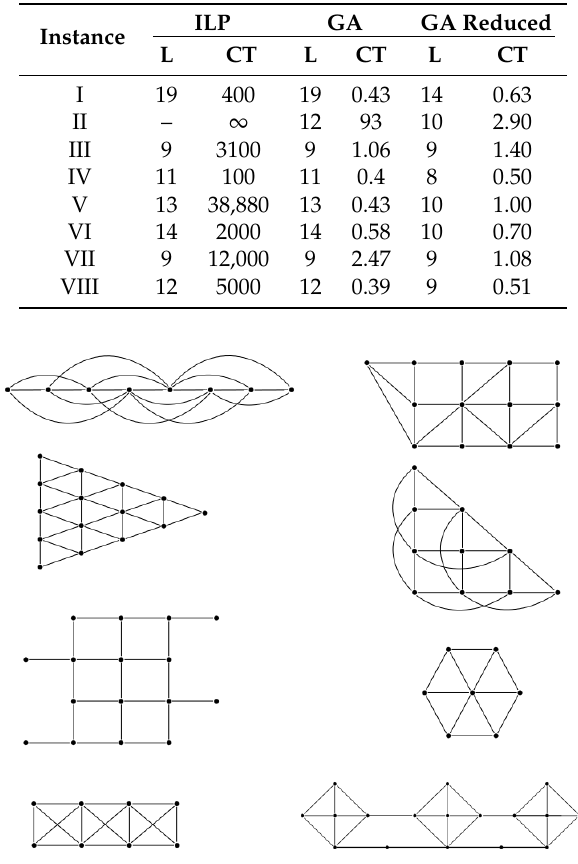
Figure 4. Different topologies evaluated in the